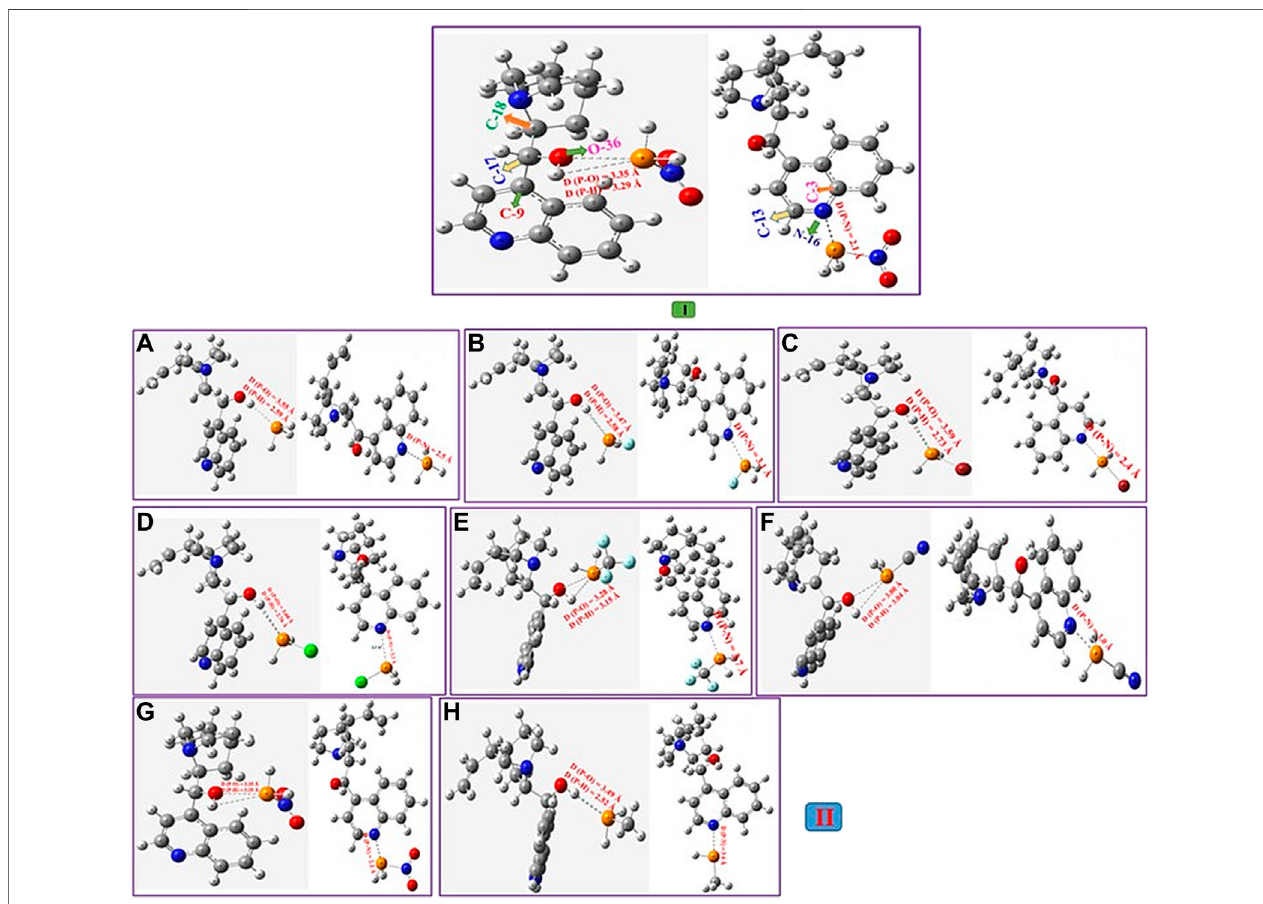
FIGURE 4 | Geometry analysis of the epi-cinchonidine complex (epi-CD-X1/epi-CD-X2) with the pnicogen bond.